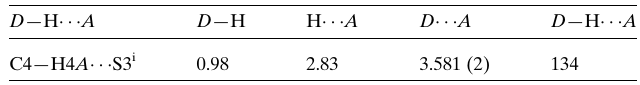
Table 1 Hydrogen-bond geometry (A˚ , (cid:5) ) for I .